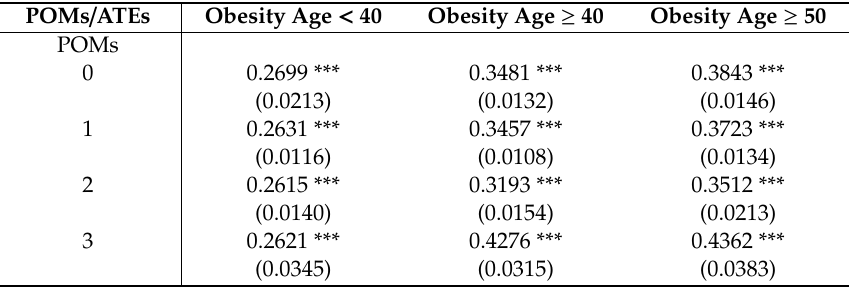
Table 9. The average treatment e ff ects on obesity for di ff erent age